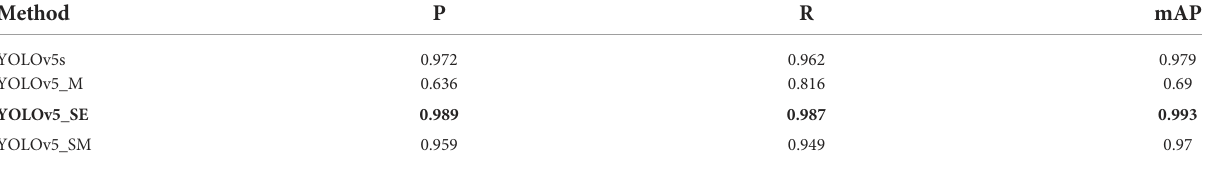
TABLE 2 Comparison of test results of four models. Method